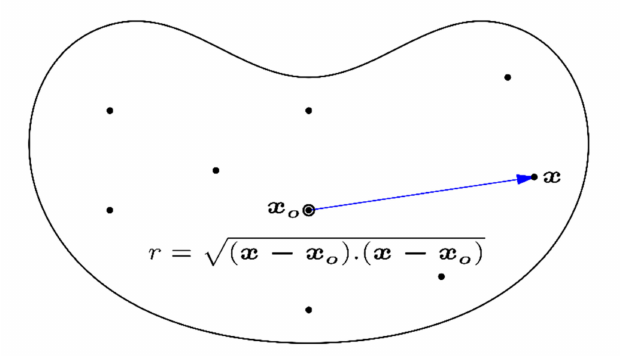
Figure 1. Schematic diagram of the distance r